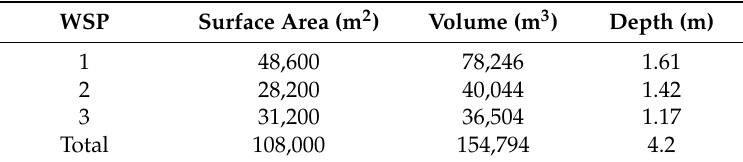
Table 1. Area, volume and depth of the wastewater stabilization ponds (WSPs)